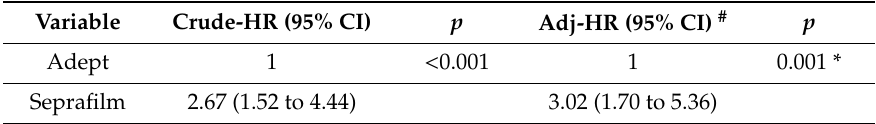
Table 6. Hazard ratio of flatus passage > 48